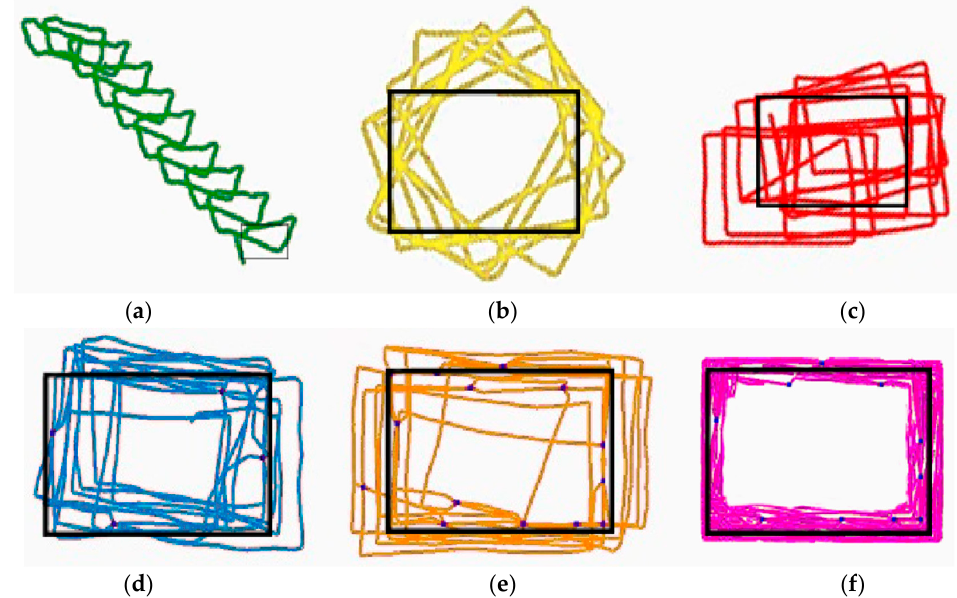
Figure 9. Localization trajectories for the ground-truth reference path for ( a ) IPmag ( b ) IPgyro ( c ) IPS ( d ) IPSPL ( e ) IPSCL ( f ) IPSCLmap.